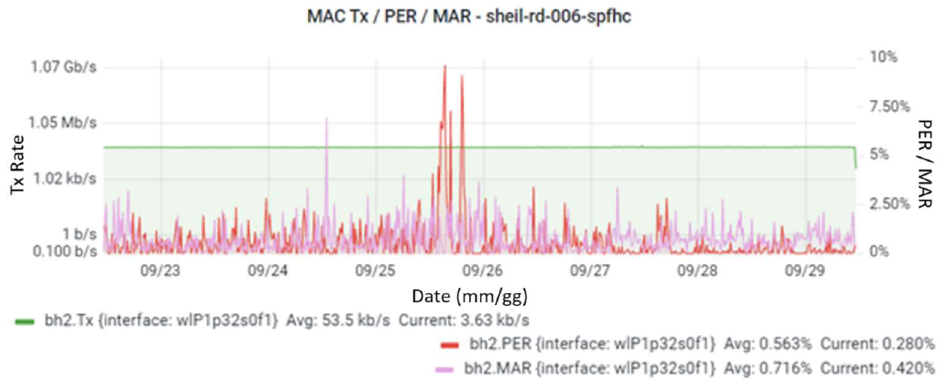
Figure 11. Performance in terms of PER of Link 3.